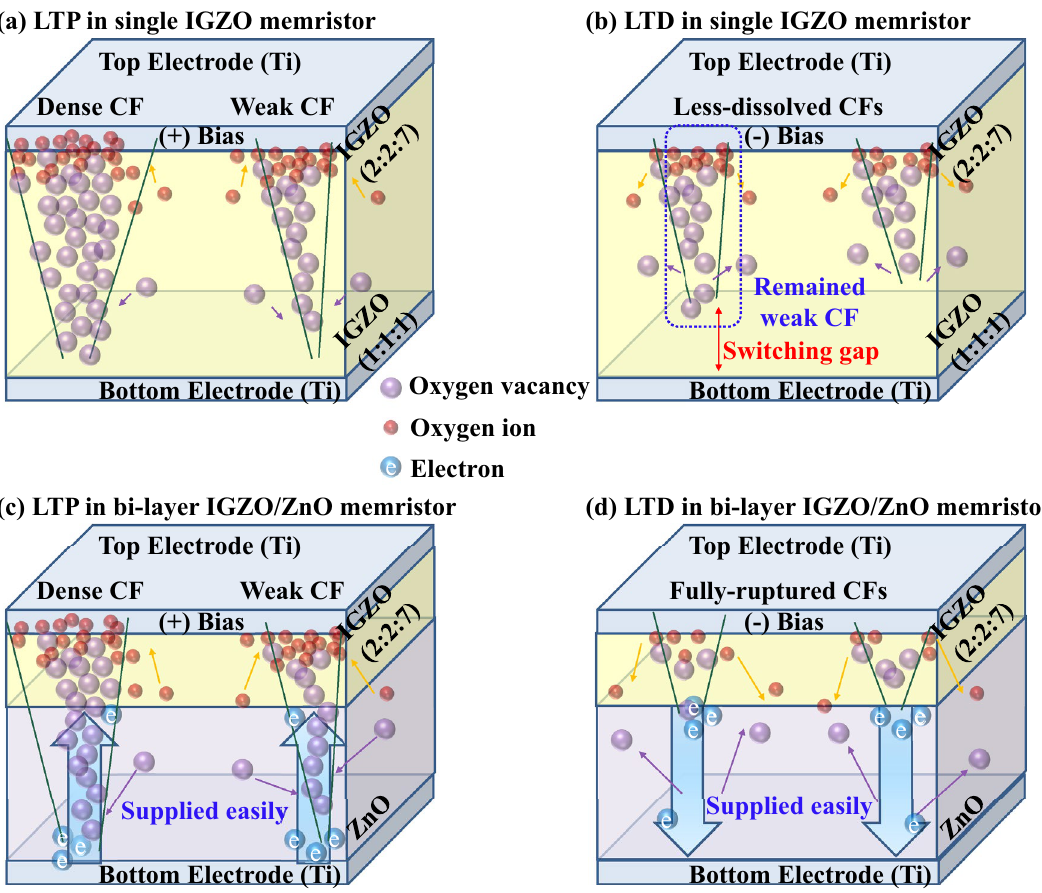
Figure 8. Schematic illustration of the transition mechanism from conductive filamentary switching for the single IGZO and bi-layer IGZO/ZnO memristors when evaluating synaptic devices corresponding to the LTP case and LTD case. ( a ), ( b ) a single IGZO, and ( c ), ( d ) bi-layer IGZO/ZnO